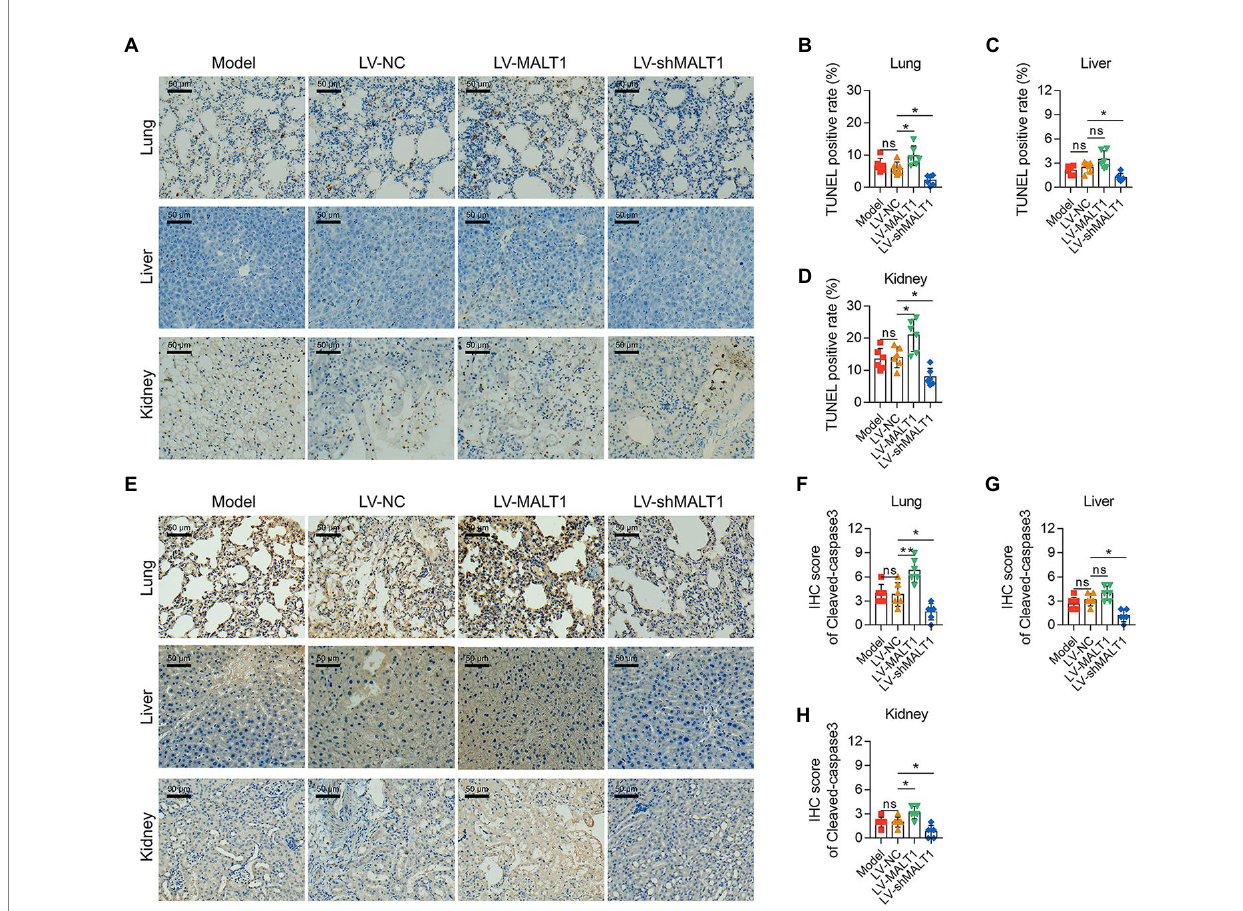
FIGURE 3 Effect of MALT1 on cell apoptosis in multiple organs of LPS-induced septic mouse model. TUNEL assay of lung, liver, and kidney tissues among the Model, LV-NC, LV-MALT1, and LV-shMALT1 groups (A) . Comparison of the TUNEL-positive rate of the lung (B) , liver (C) , and kidney (D) among the Model, LV-NC, LV-MALT1, and LV-shMALT1 groups. IHC analysis of cleaved-caspase3 in lung, liver, and kidney tissues among the Model, LV-NC, LV-MALT1, and LV-shMALT1 groups (E) . Comparison of cleaved-caspase3 IHC scores of the lung (F) , liver (G) , and kidney (H) among the Model, LV-NC, LV-MALT1, and LV-shMALT1 groups. n = 6 in each group. One-way ANOVA plus Tukey’s post hoc test was applied. Ns, not significant; * p < 0.05; ** p <